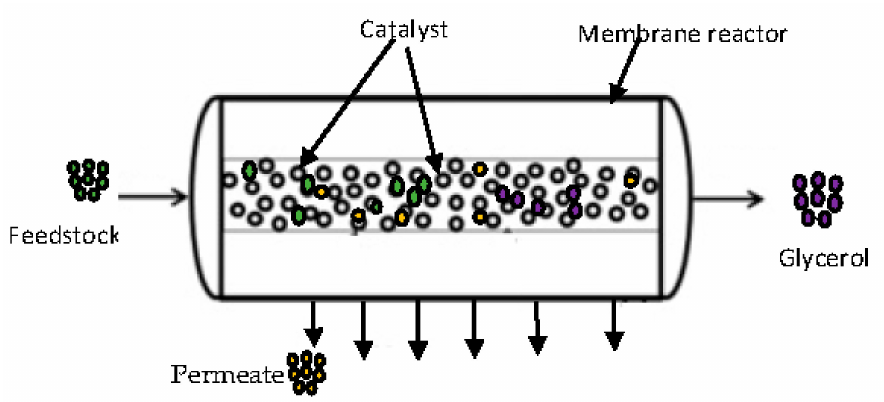
Figure 2. A schematic diagram showing the feedstock and membrane-catalyst interactive